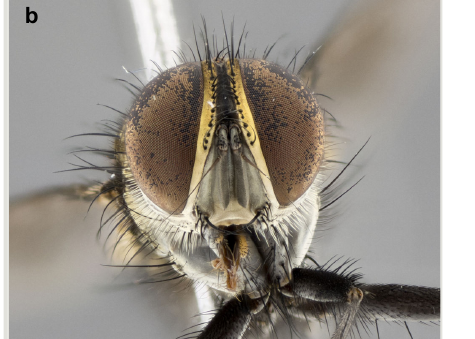
c Figure 13. General morphology of Calolydella discalis sp. n. ; a–c : male holotype, voucher n.